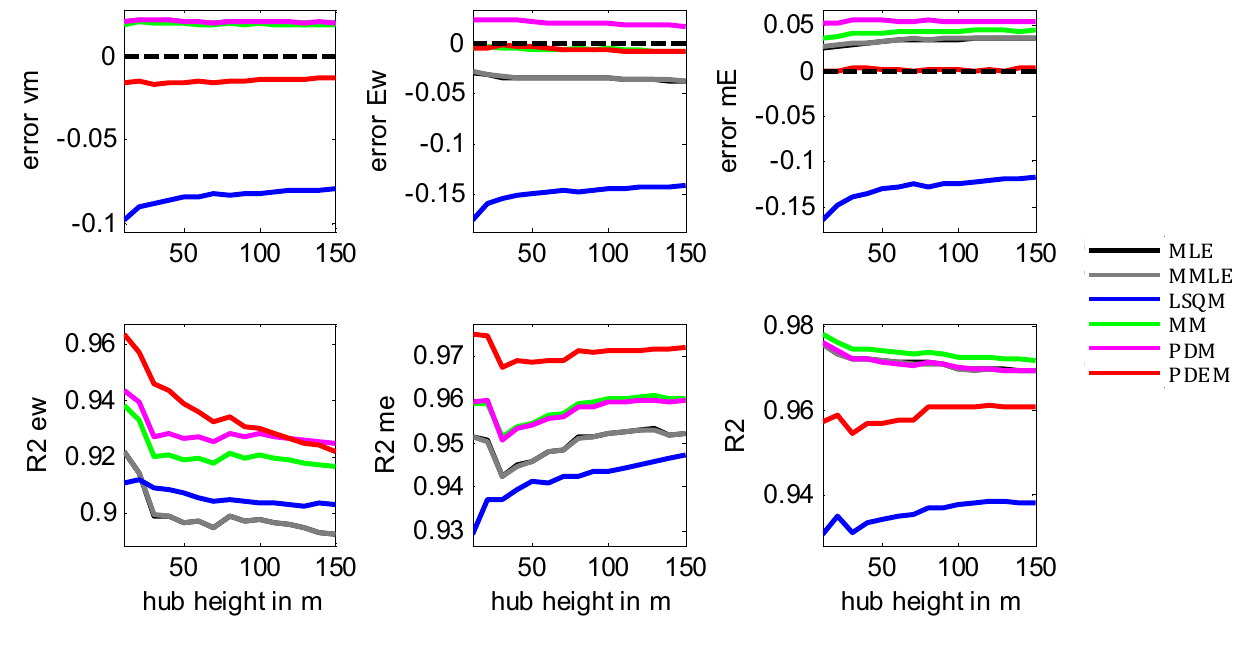
Figure 18. Mean values of the indicators of the fitness ( error and R 2 ) at different hub R 2 me